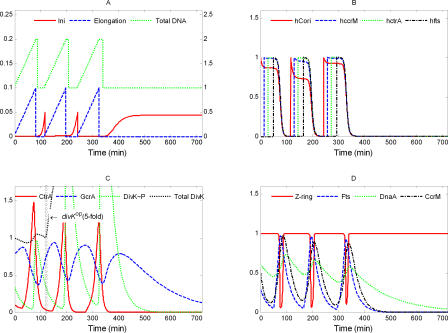
Simulation of divKop: k
s,DivK = 0, k′ = 0.027 (5 × WT)